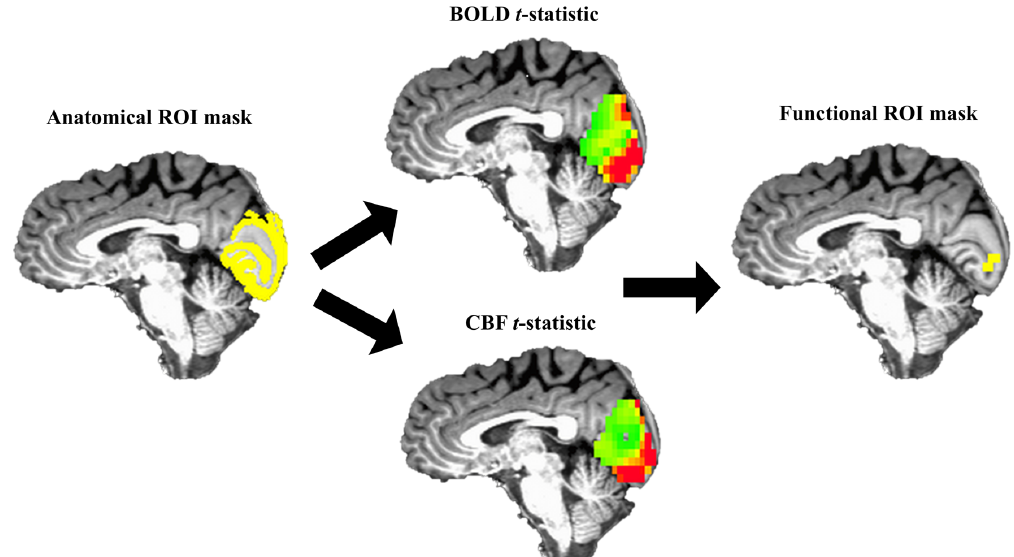
Figure 3. Graphical overview of masking procedure. For each participant, their top 5%, overlapping BOLD and CBF t -statistics (middle) within the anatomical ROI (left, yellow) were used to create the functional ROI mask (right, yellow). Functional measures (veBOLD, veCBF, veCMRO 2 , and ve n ) were extracted from each participant’s functional ROI mask.